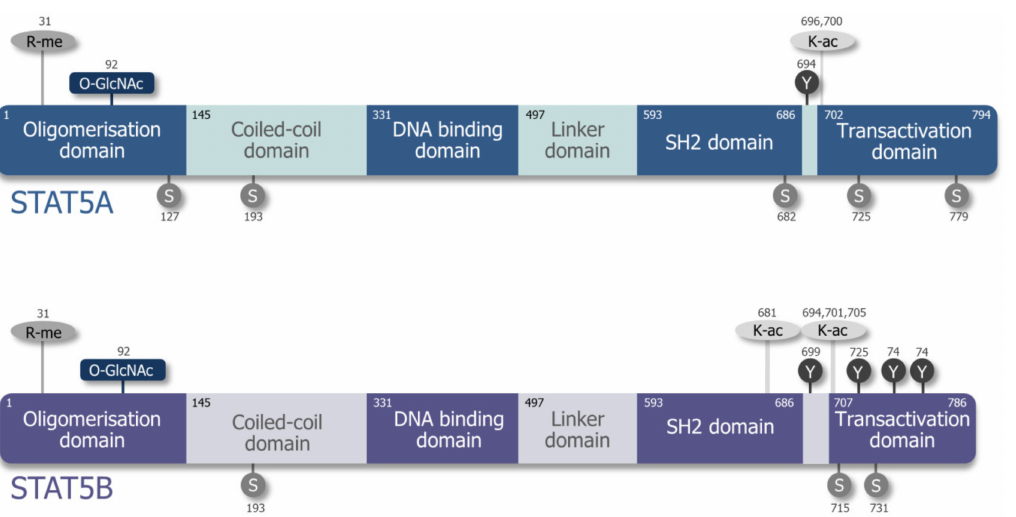
Figure 1. Di ff erences in the domain structure and post-translational modifications of STAT5A and STAT5B. The protein structure of human STAT5A and STAT5B, including the most prominent Serine (S) and Tyrosine (Y) phosphorylation, Arginine methylation (R-me), and Lysine acetylation (K-ac), as well as O-GlcNAc sites, are